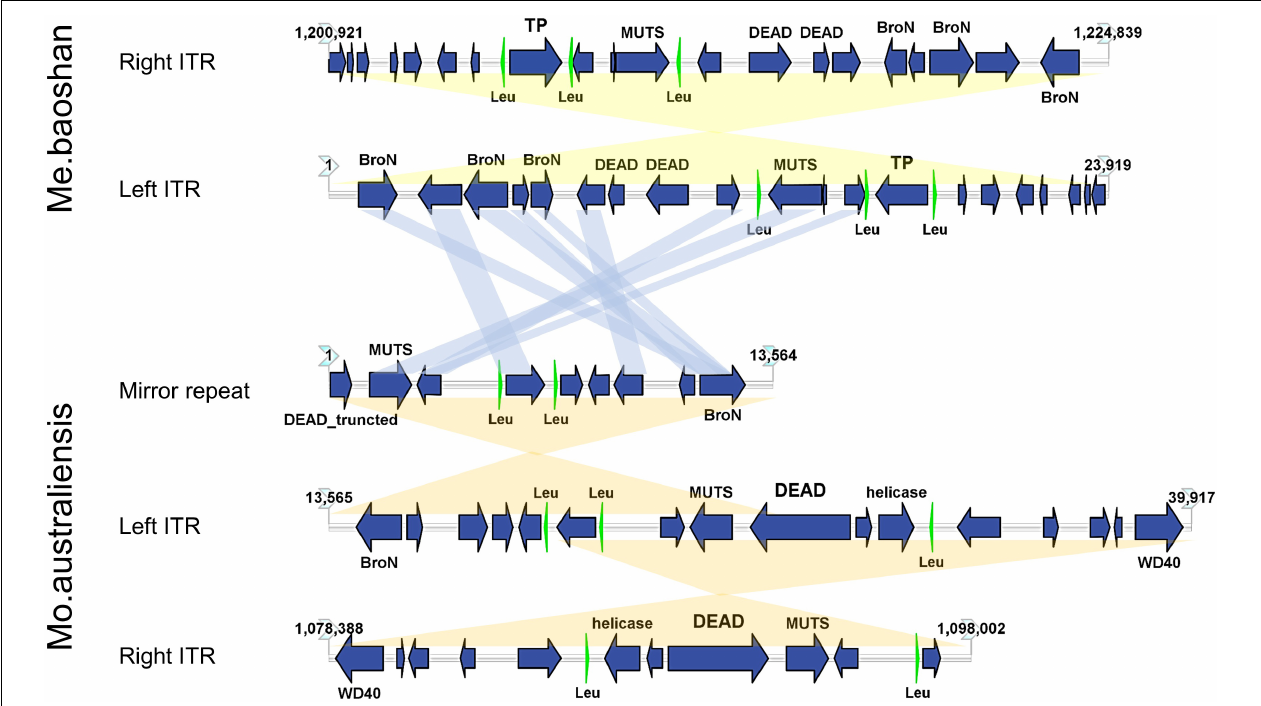
FIGURE 6 | Map of ITRs of Me. baoshan and Mo. australiensis displaying the relative size and direction of ORFs (blue) and tRNA (green). Links in light blue represented the homologue proteins between different viral ITRs, and links in light yellow represented ITRs and mirror repeat within a viral genome. Map of Mo. Australiensis was made using sequence data in GeneBank (MG807320.1). BroN, Bro-N domain-containing protein; DEAD, DEAD-like helicase; MUTS, MUTS family DNA-binding domain protein; TP, transposase; WD40, WD40 repeat protein; Leu,